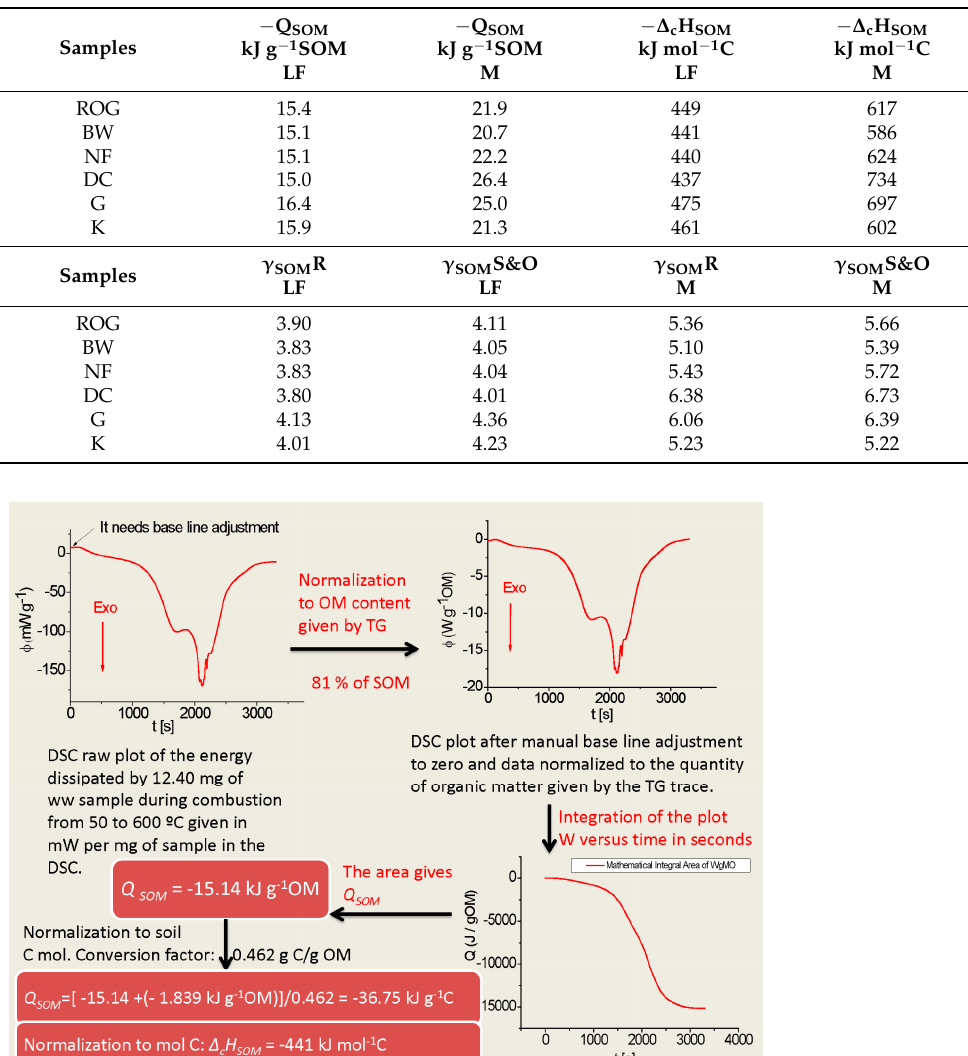
Table 2. Thermodynamic data of samples obtained directly from DSC curves, Q SOM and ∆ c H SOM , and the degree of reduction of samples, γ SOM determined by Roels, γ SOM R, and Sandler and Orbey, γ SOM S&O, correlations for the LF soil layer and mineral soil samples, M. Samples ROG, BW, and NF are from the southeast of the UK. Samples DC, G, and K are from the southwest of Ireland. The reproducibility of measurements by DSC–TG is 5%. The uncertainty averaged for the degree of reduction is ± 0.2 based on the standard errors reported for both models [27,28].